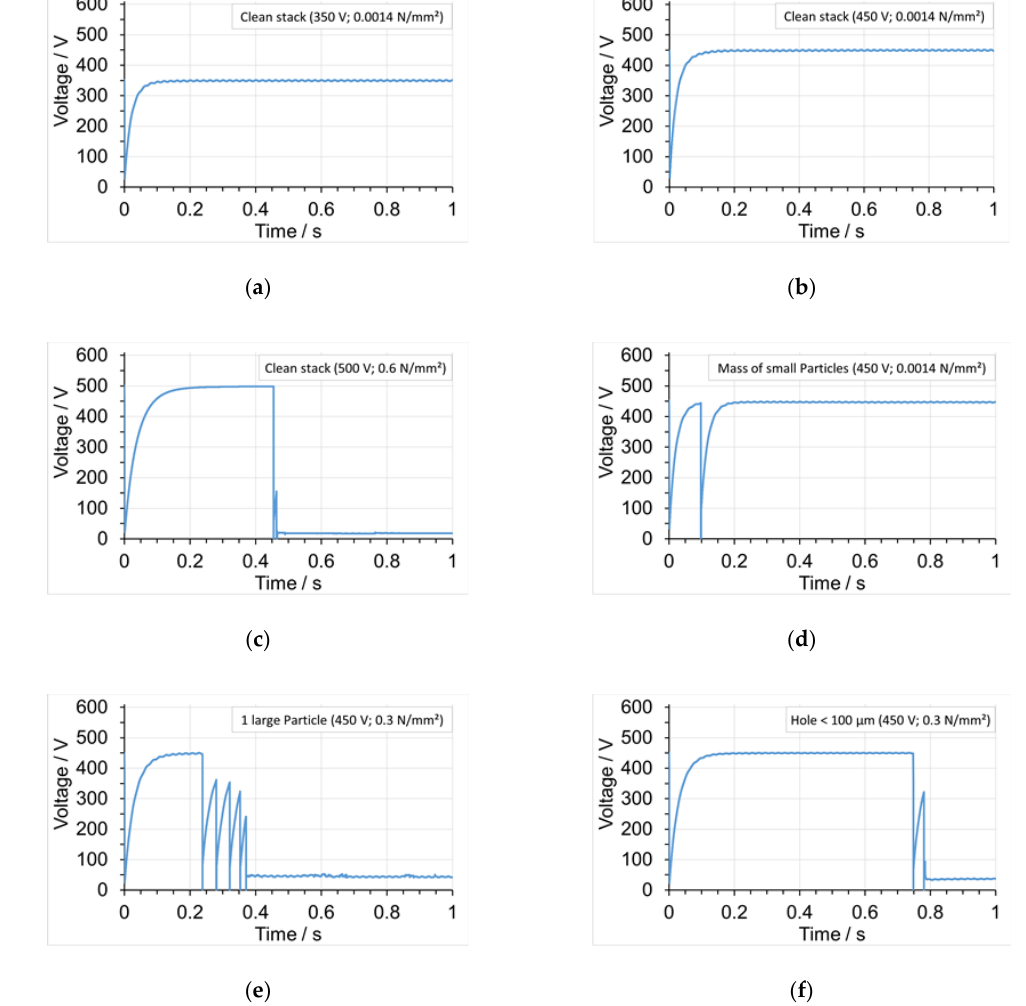
Figure 4. Voltage curves of clean cell stacks ( a – c ) and cell stacks with defect structures ( d – f ). Clean stacks at ( a ) 350 V, ( b ) 450 V, and ( c ) 500 V, the latter with a hard-discharge (HD) and no recovery. Cell stacks with defect structures charged up to 450 V: ( d ) mass of small particles with HD and full recovery; ( e ) one large particle with several HD events and partial recovery; ( f ) hole with HD and no recovery. The mechanical pressures are given in the insets.